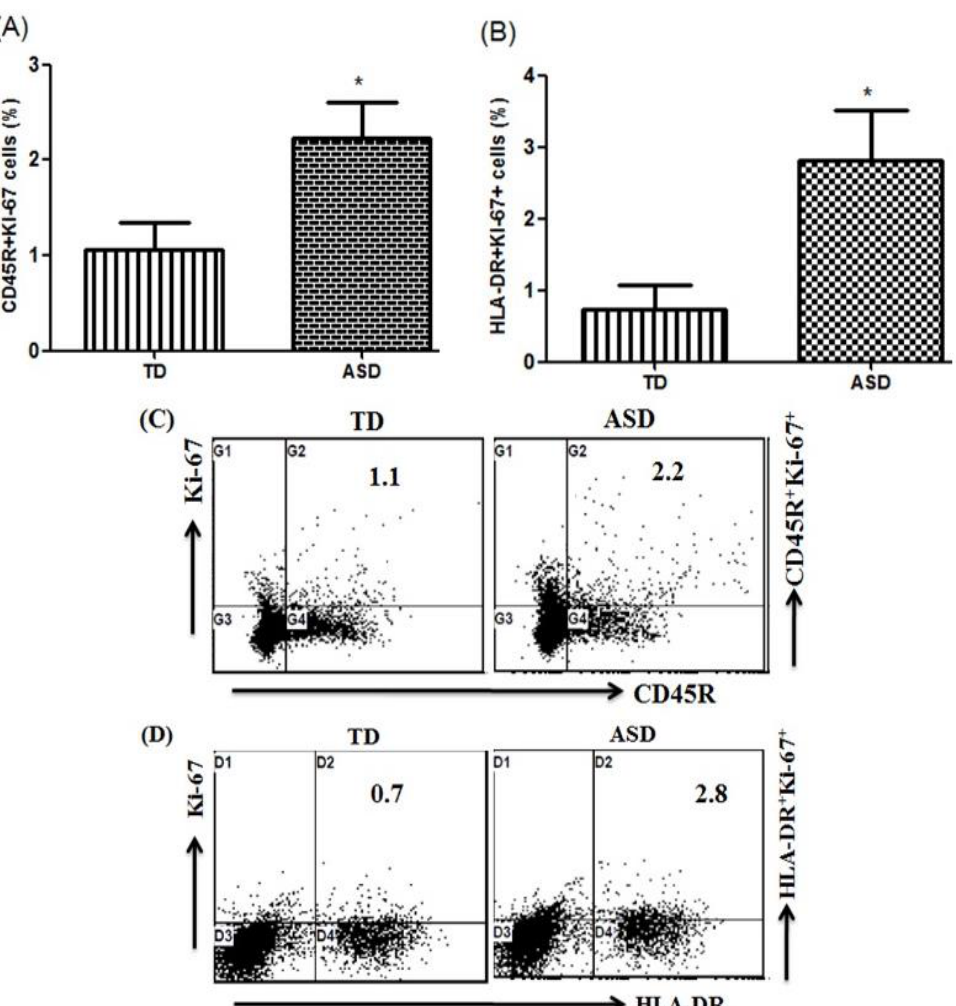
Figure 3. Ki-67 expression in CD45R+ and HLA-DR+ peripheral blood mononuclear cells (PBMCs). ( A , B ) Flow cytometric analysis of Ki-67-producing CD45R+ and HLA-DR+ PBMCs in children with autism spectrum disorder (ASD) and typically developing (TD) controls. ( C , D ) Representative flow cytometry dot plots showing the percentage of Ki-67-producing CD45R+ and HLA-DR+ PBMCs from TD controls and children with ASD. Statistical analysis was carried out by Student’s t -test. Statistical significance was determined as * p < 0.05.